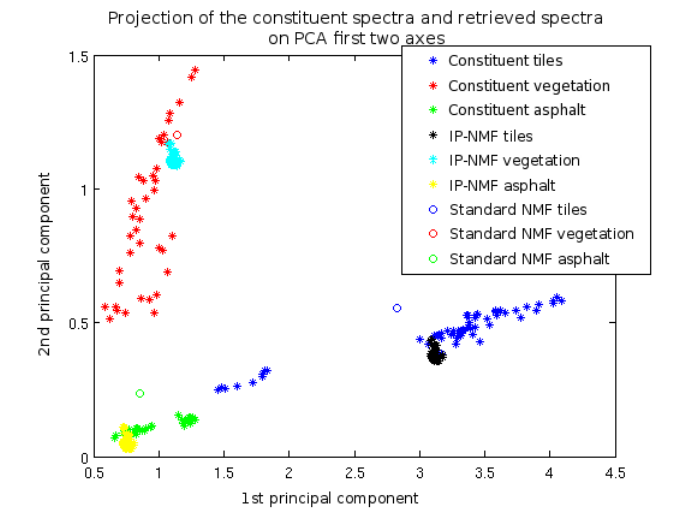
Figure 8. Projection onto the first two PCA axes of constituent spectra (blue, red, green stars), IP-NMF spectra (black, cyan, yellow stars) with µ = 100 and standard NMF spectra (blue, red, green circles).